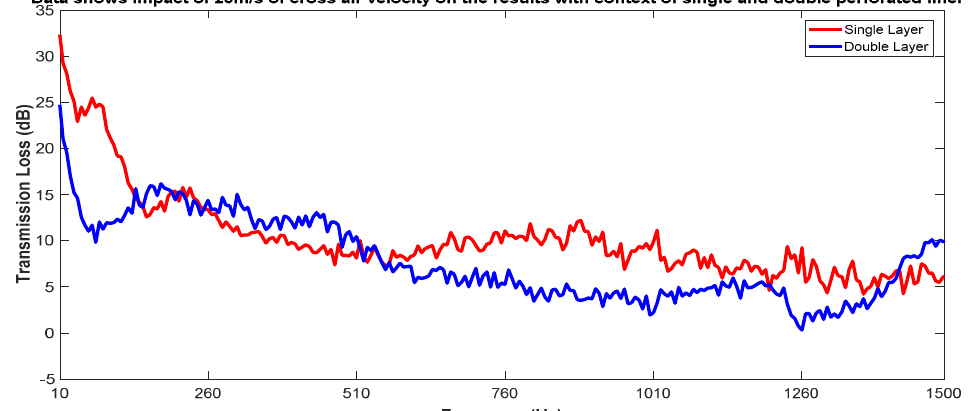
Fig. 7. The acoustic transmission loss versus frequency. The data were collected with air cross-velocity equal to (20m/s) using the perforated